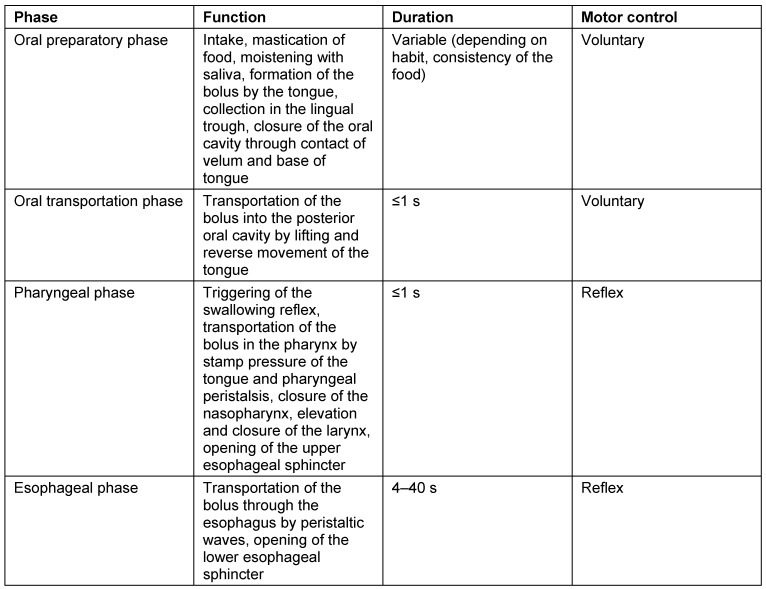
Phases of swallowing (according to [37])